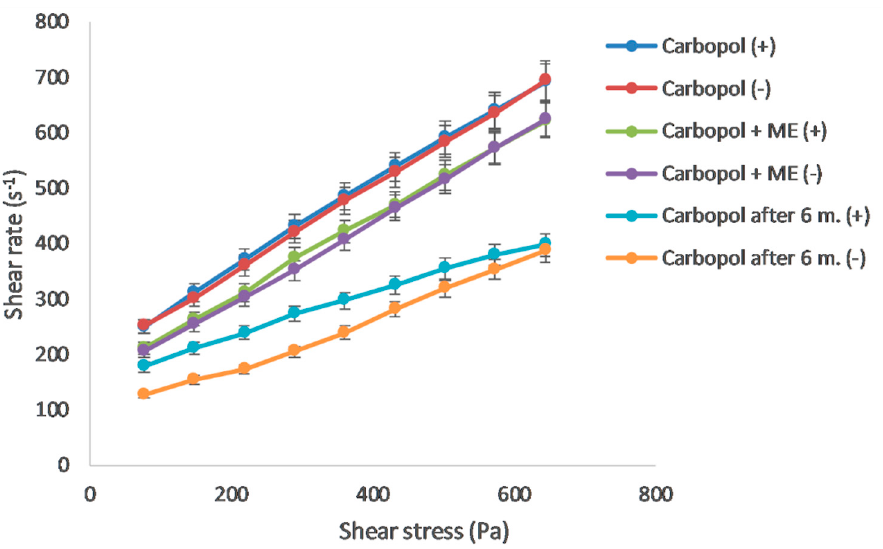
Figure 2. Rheogram for Carbopol gel, ME-containing Carbopol gel, and Carbopol gel after 6 months; (+) up-curve, ( − ) down-curve.